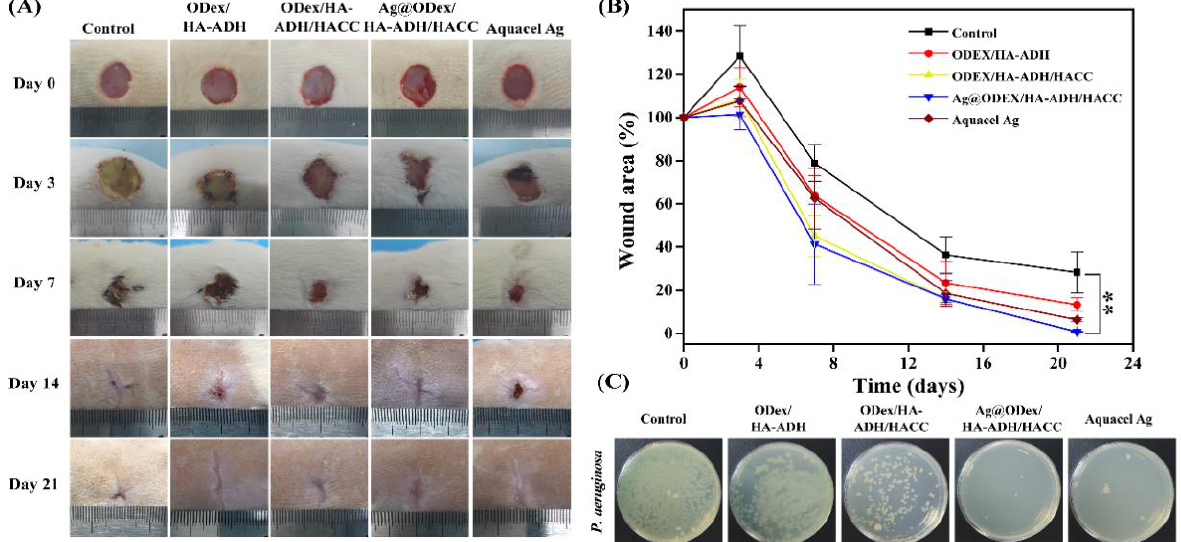
Figure 5. In vivo wound healing behavior. ( A ) Digital images of wound area 3-, 7-, 14- and 21-days post-treatment in different groups. ( B ) Quantitative measurements of the wound area over 21 days. ( C ) Quantitation analysis the number of P. aeruginosa remaining in the wound area at day 3.